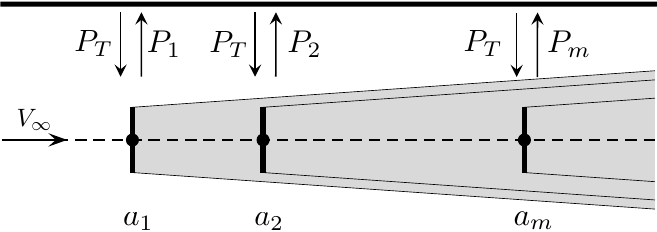
Figure 5. Typical decentralized control scheme. Each wind turbine has information about the total generated power and its own axial induction factor.